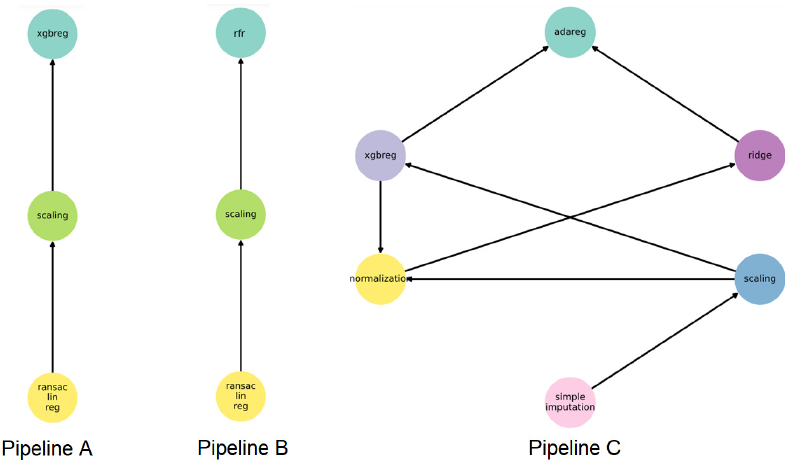
Figure 13. Pipelines of created predictive models for three-time